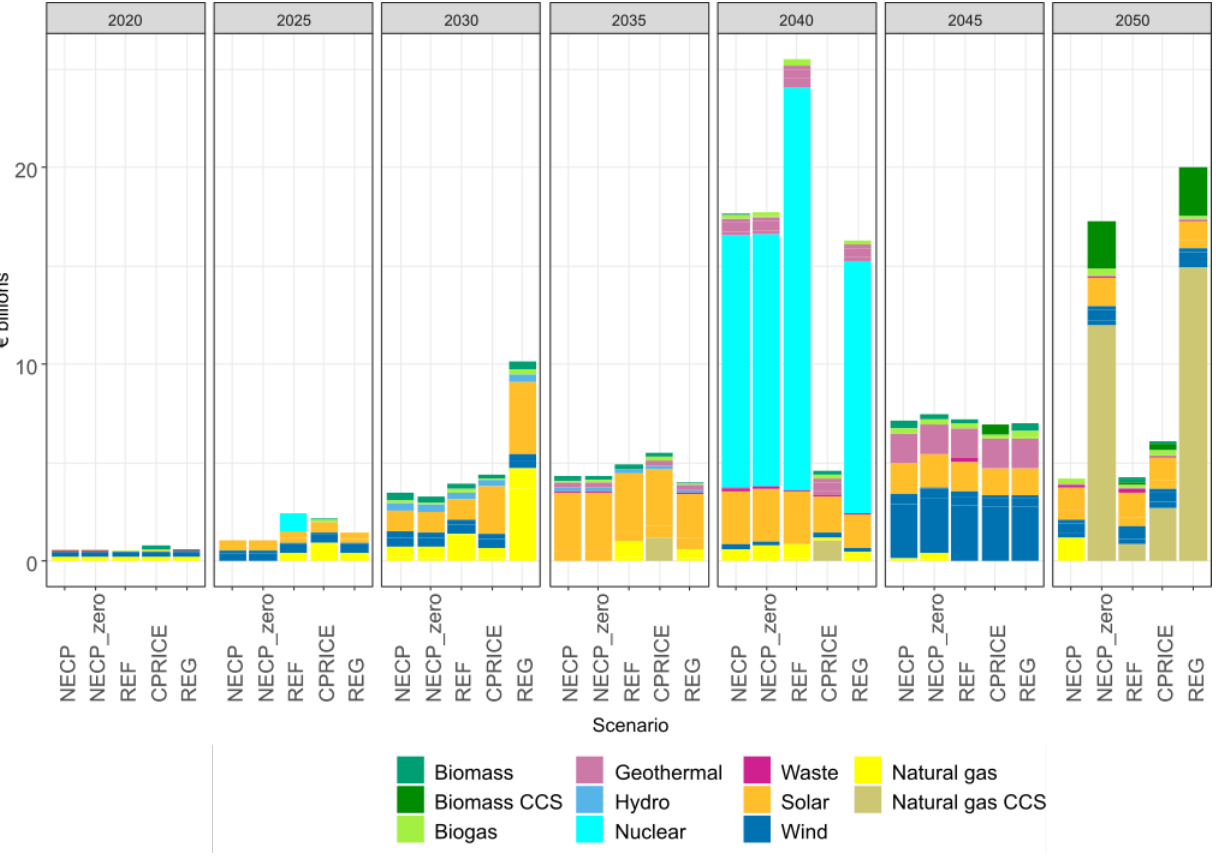
Figure 11. Investment cost — heat and power generation (sum over 5-year period, EUR 2020, with- out VAT).